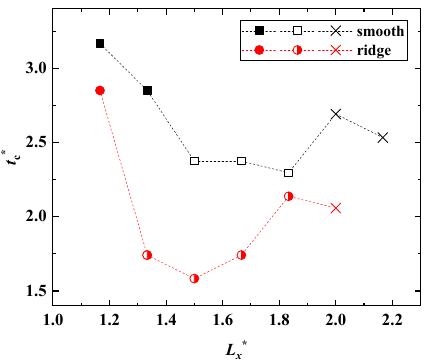
Figure 15. The variations of the contact time with L x * on the S3 surface.